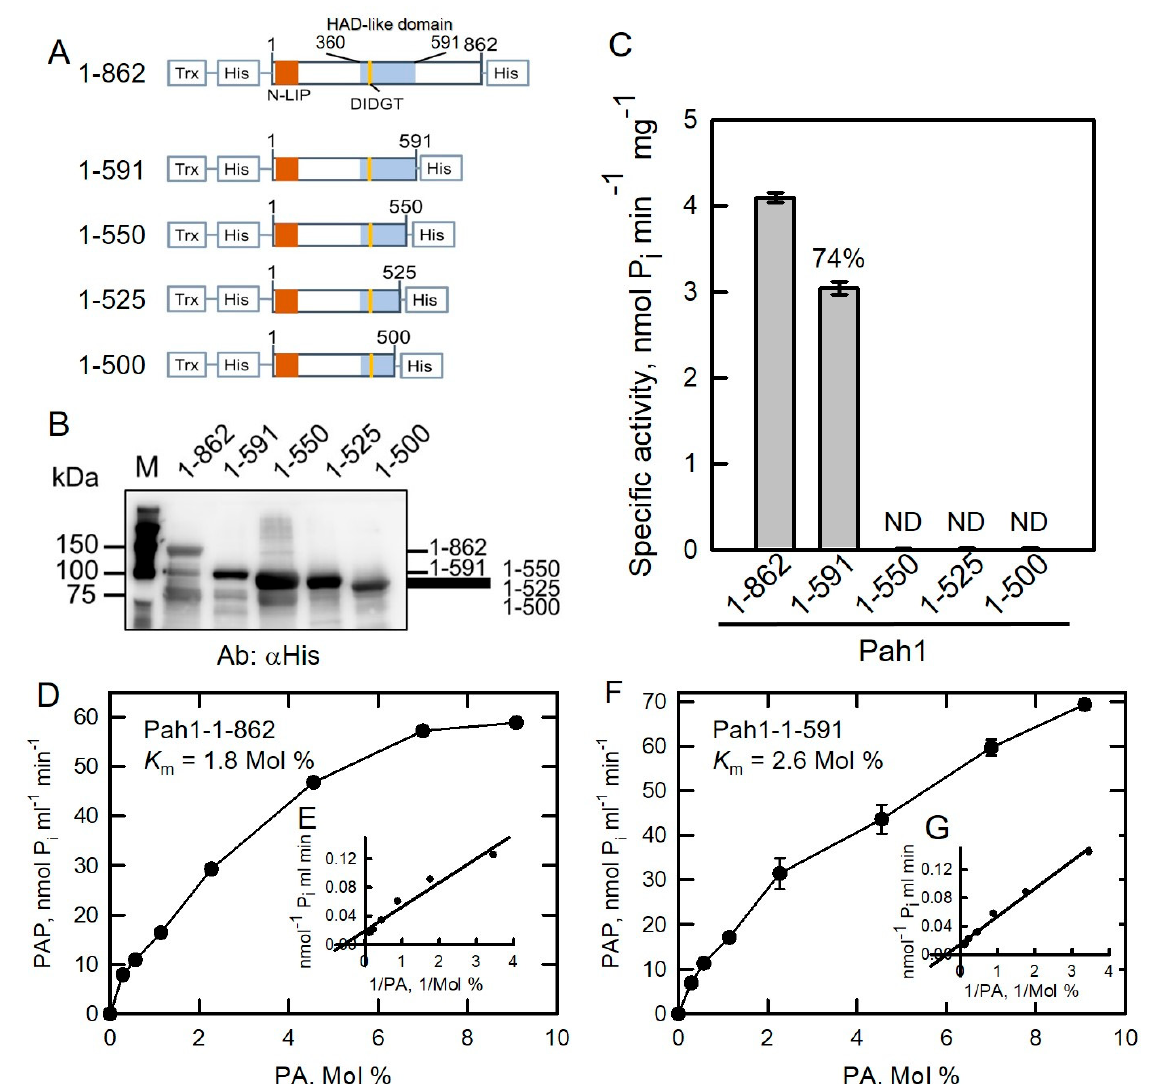
Figure 2. HAD-like domain is essential for Pah1 catalytic activity. ( A ) The full-length and truncated Pah1 proteins fused with thioredoxin (Trx) and His 6 -tags at both termini. ( B ) Pah1 truncations were expressed in E. coli and purified by Ni-NTA resin. Proteins were subjected to SDS-PAGE followed by Western blotting analysis with the anti-His antibodies. ( C ) PAP activities were measured in Pah1 truncations. ( D ) Substrate saturation curve and Lineweaver–Burk double reciprocal plot ( E ) of the initial rate result of Pah1-1-862. ( F ) Substrate saturation curve and Lineweaver–Burk double reciprocal plot ( G ) of the initial rate result of Pah1-1-591. The data are the average of triplicate experiments ± S.D. (error bars). ND, not detected.